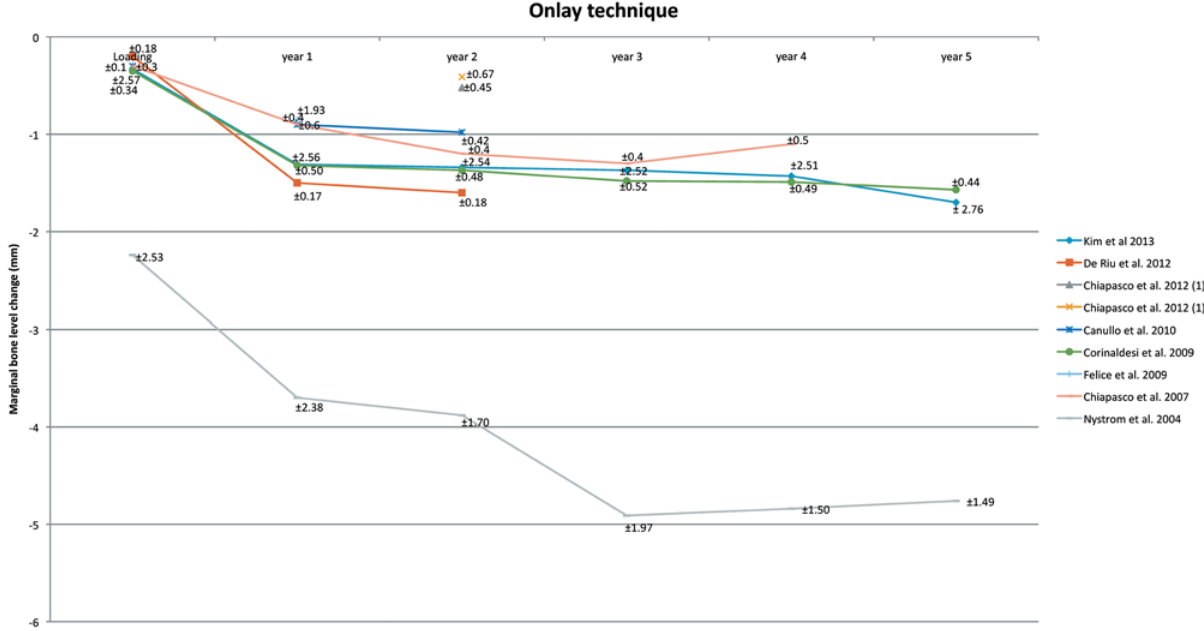
Figure 5- Onlay technique. Mean and Standard Deviation are indicated